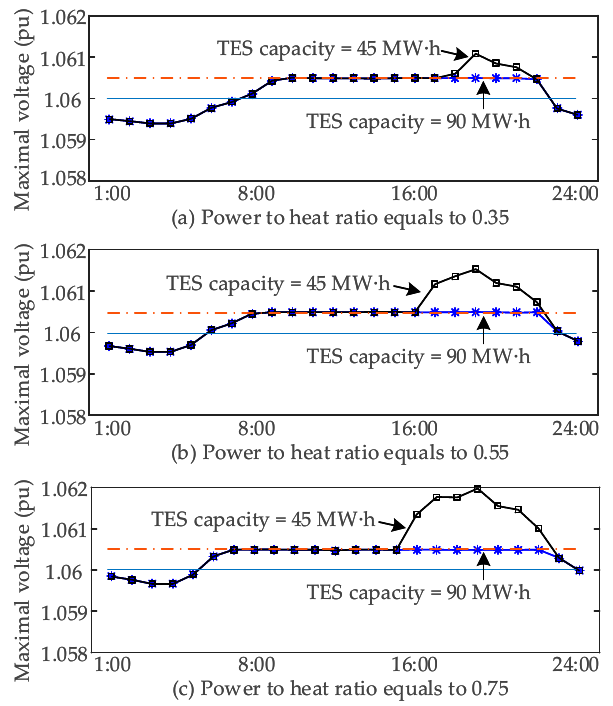
Figure 12. Impacts of TES capacity on voltage regulation (power to heat ratio of CHP generation is set with diverse value, where ( a ) C = 0.35; ( b ) C = 0.55; and ( c ) C = 0.75).